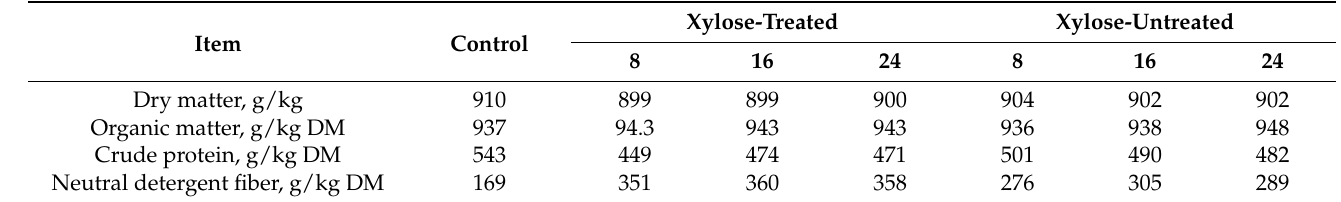
Table 1. Chemical composition of experimental ingredients of Experiment 1—autoclave.